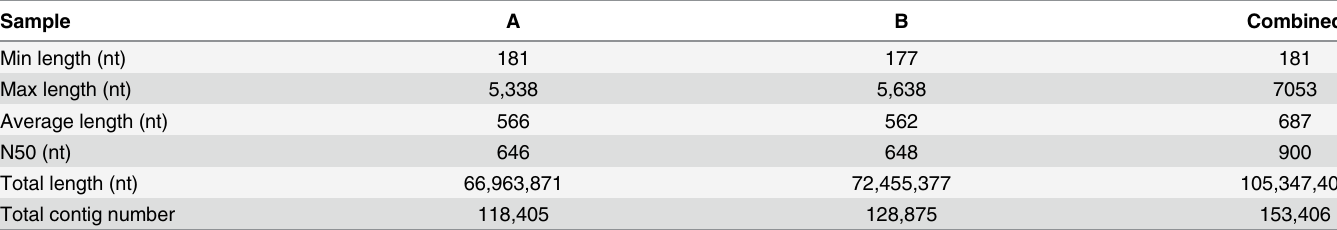
Table 2. Statistical analysis of assembled contigs.